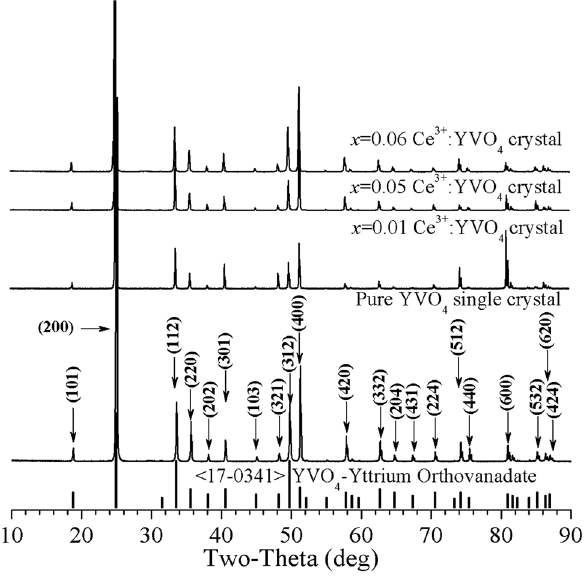
Figure 2: XRD patterns of the pure YVO 4 and Ce 3 + - doped YVO 4 crystals.